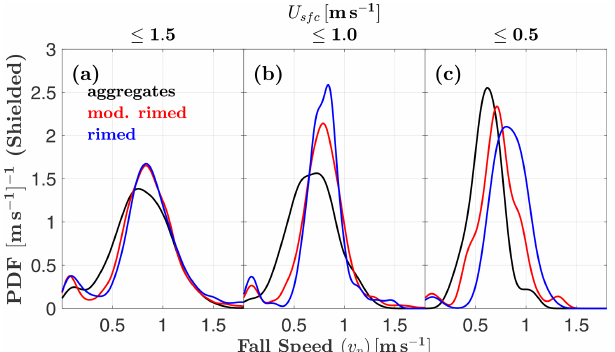
Figure 6. PDF estimates for shielded MASC fall speed v p for very light wind speeds and hydrometeors divided into three riming classes: sparsely rimed aggregates, moderately rimed, and